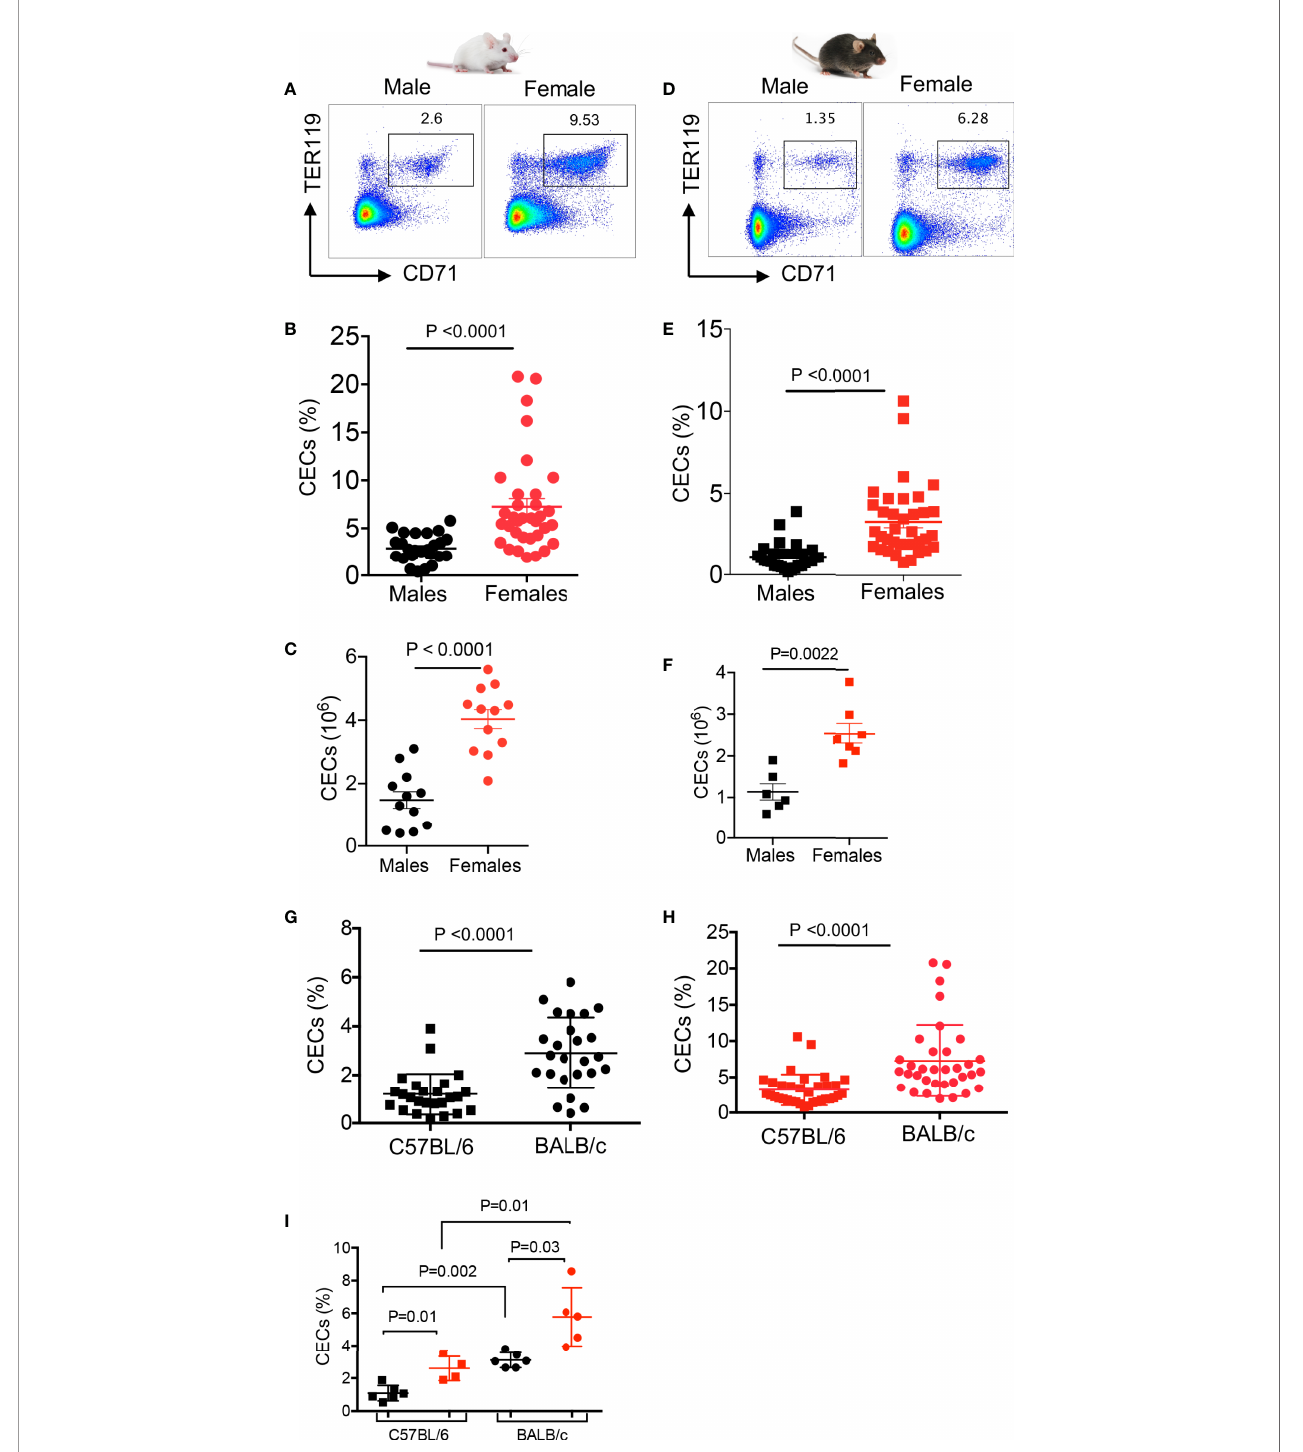
FIGURE 1 | Higher frequency of CECs in female versus male mice. (A) Representative fl ow cytometry plots, (B) cumulative data of percentages, and (C) absolute numbers of CECs in spleens of BALB/c male and female mice. (D) Representative fl ow cytometry plots, (E) cumulative data of percentages, and (F) absolute numbers of CECs in spleens of C57BL/6 male and female mice. (G) Cumulative data comparing percentages of CECs in spleens of C57BL/6 and BALB/c male mice. (H) Cumulative data comparing percentages of CECs in spleens of C57BL/6 and BALB/c female mice. (I) Cumulative data comparing percentages of CECs in spleens of C57BL/6 male and female, and BALB/c male and female littermates at 8 weeks old. Each point represents data from an individual mouse, representative of at least three independent experiments. Bar, mean ± standard